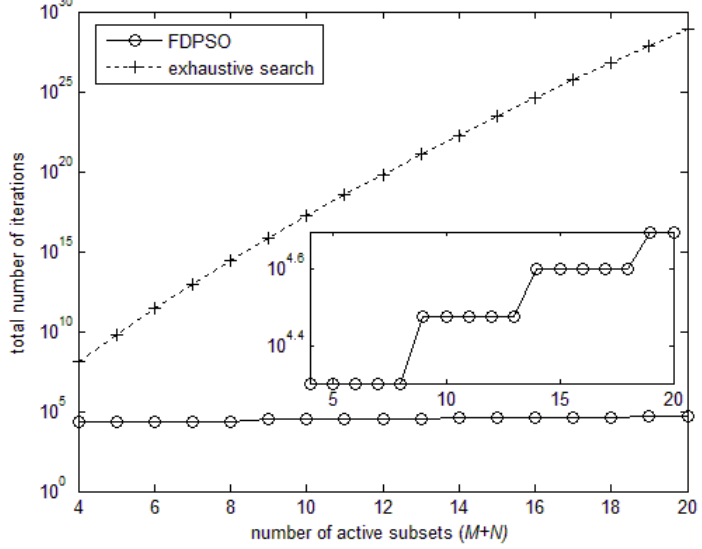
Figure 4. Comparison of the square root of trace of PCRLB.